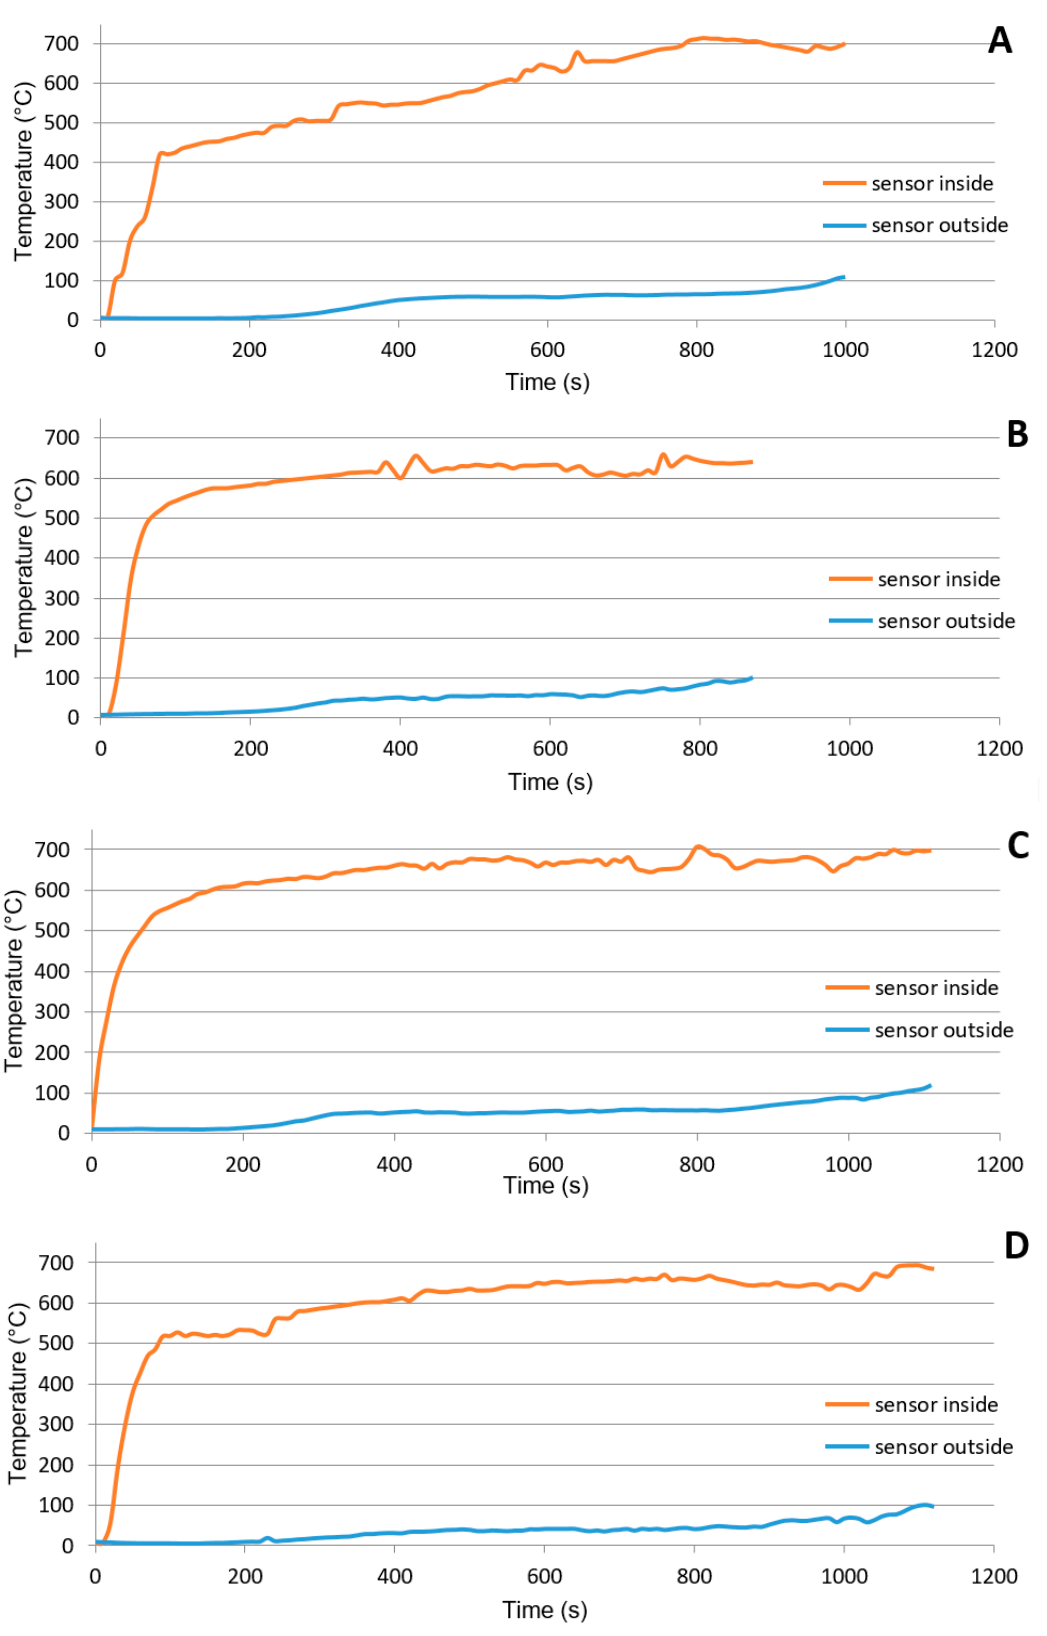
Figure 6. Influence of panel composition on burning characteristics, ( A ) board density 340 kg/m 3 , geop. density 885 kg/m 3 ; ( B ) board density 500 kg/m 3 , geop. density 885 kg/m 3 ; ( C ) board density 340 kg/m 3 , geop. density 915 kg/m 3 ; ( D ) board density 500 kg/m 3 , geop. density 915 kg/m 3 .